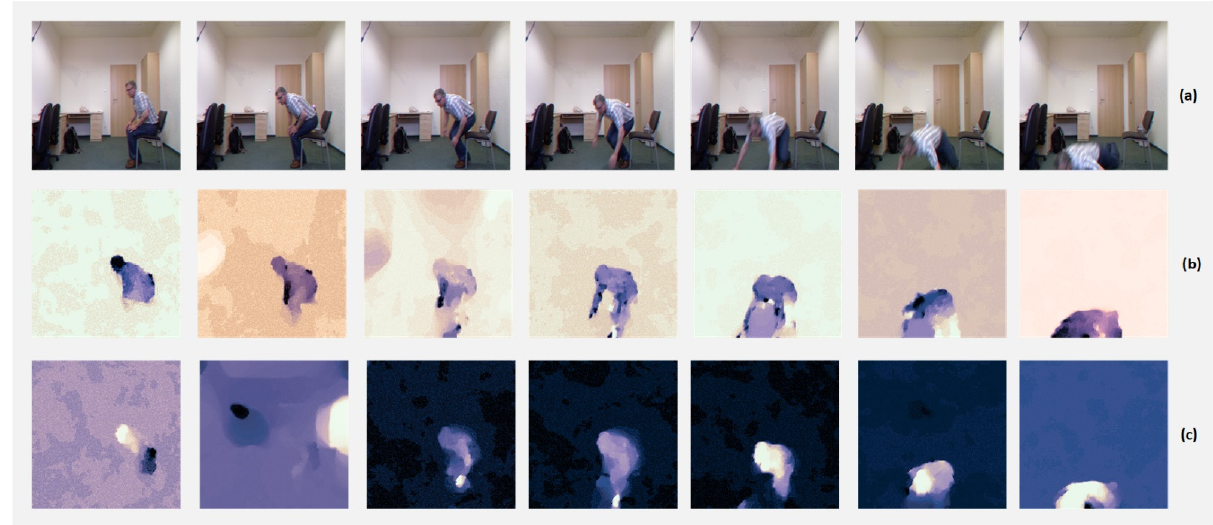
Figure 3. ( a ) Sample frames sequence pertaining to falling from URFDS; ( b ) their corresponding optical flow horizontal displacement; ( c ) optical flow vertical displacement.